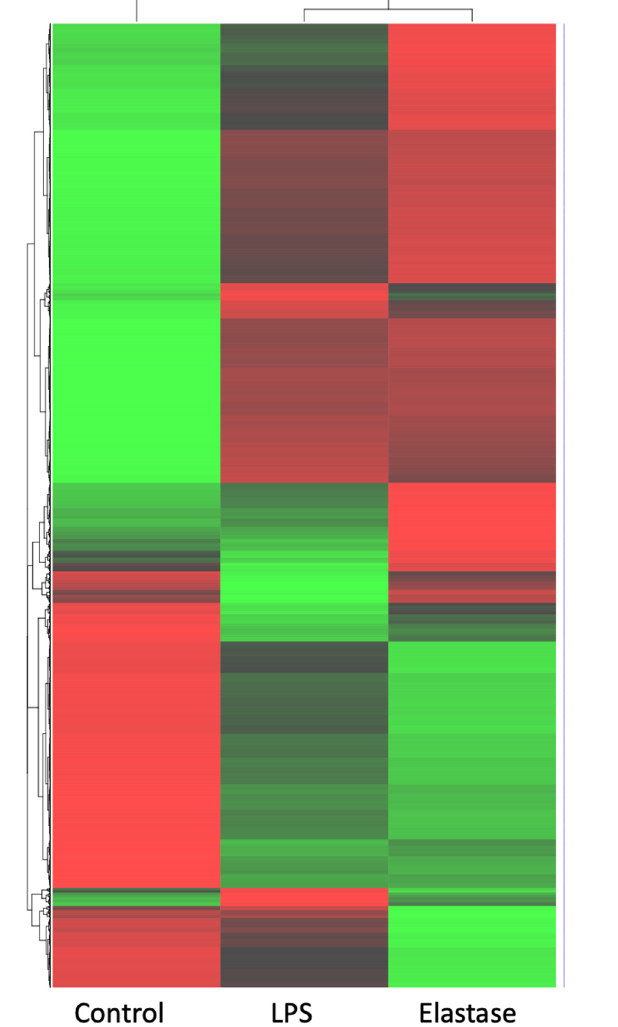
Figure 2. Cluster analysis heatmap of differentially expressed genes with high (red) expression levels and genes with low (green) expression levels. Cluster analysis of high and low expressed genes revealed significant differences. Elastase and LPS were clearly different from control, but they were also clearly different from each other.